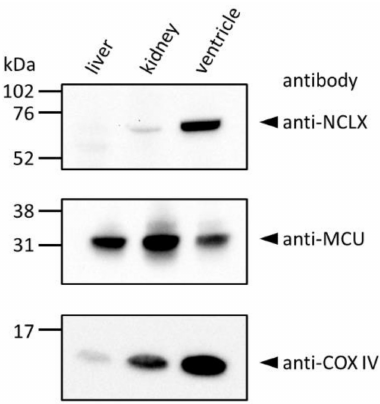
Figure 2. Western blot analyses of mouse liver, kidney and ventricular mitochondria. Isolated mitochondria (25 µ g) were used for the experiments. The identity of mitochondria was confirmed by using anti-MCU and anti-COX IV